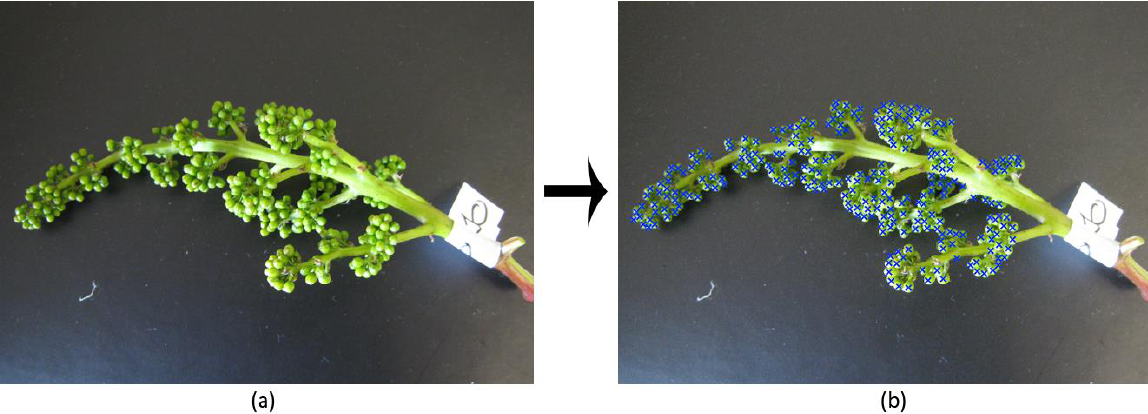
Figure 1. ( a ) Grapevine photo taken in the vineyard using black cardboard as the background; ( b ) result of the image analysis algorithm overviewed in Section 2.1 for automatically detecting flowers. Detected flower centers are marked with blue